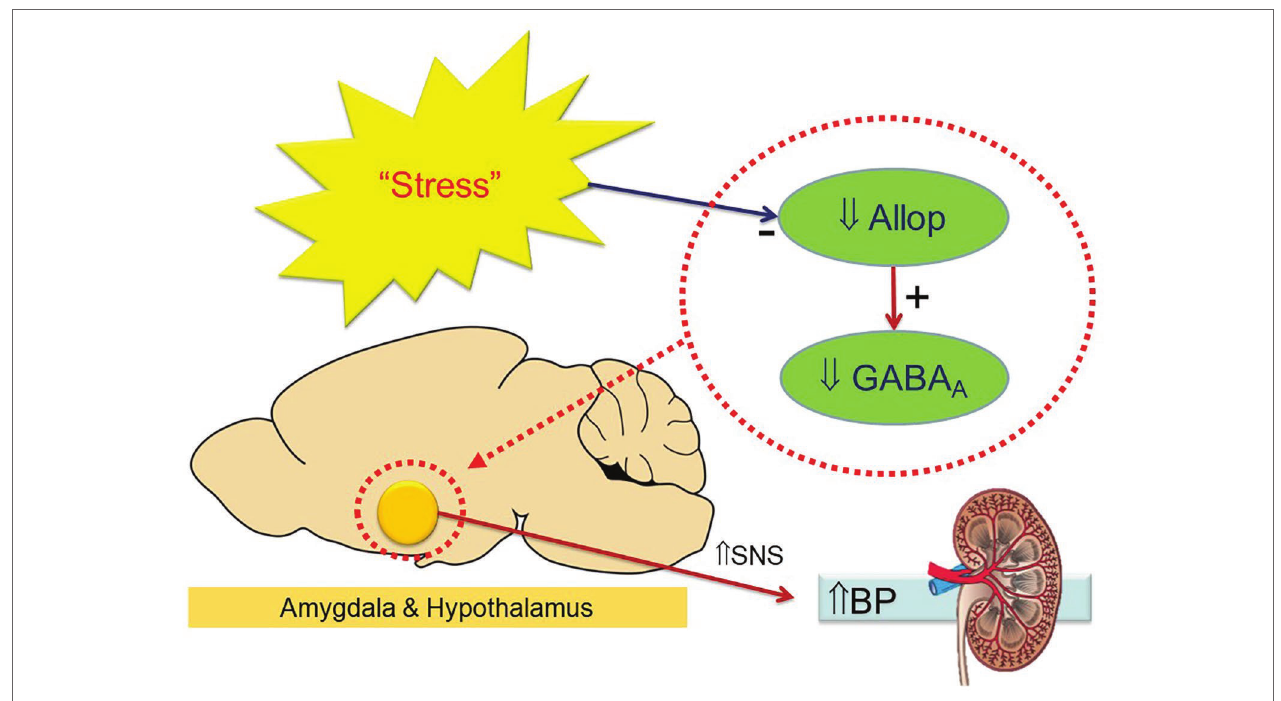
FIGURE 1 | Schema indicating the hypothesis that chronic stress reduces endogenous allopregnanolone (Allop) in the hypothalamus and amygdala leading to a reduced expression of GABA A receptors and an increase in sympathetic activity (to kidney and other organs) to elevate blood pressure. Treatment with neurosteroids reverses this